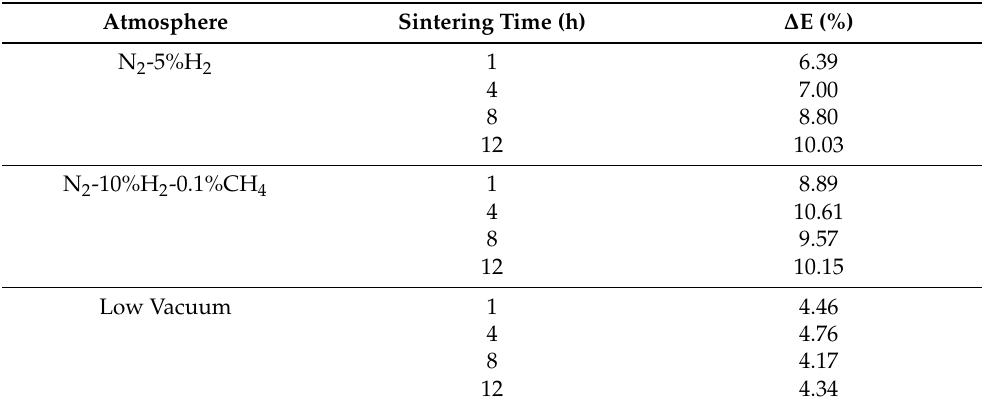
Table 5. ∆ E-effect as a function of the atmosphere and the holding times for samples sintered at 1325 °C.